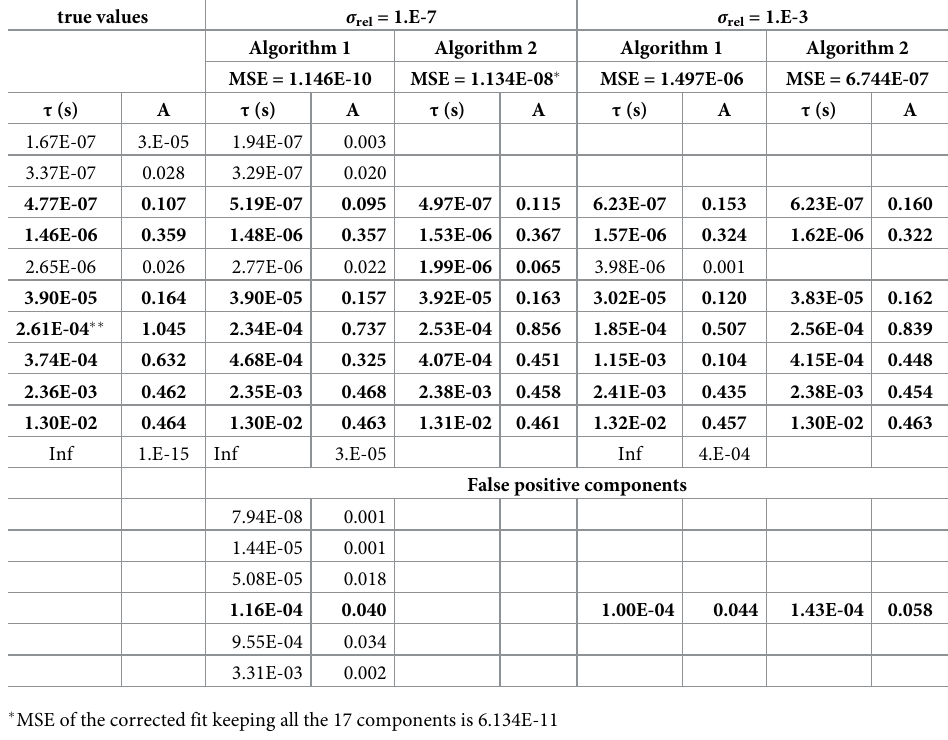
Table 1. Kinetic parameters ( τ and A) predicted at low and high noise levels on the simulated data by Algorithm 1 and Algorithm 2 (8 exponentials). MSE refers to the mean square error of the fit. true